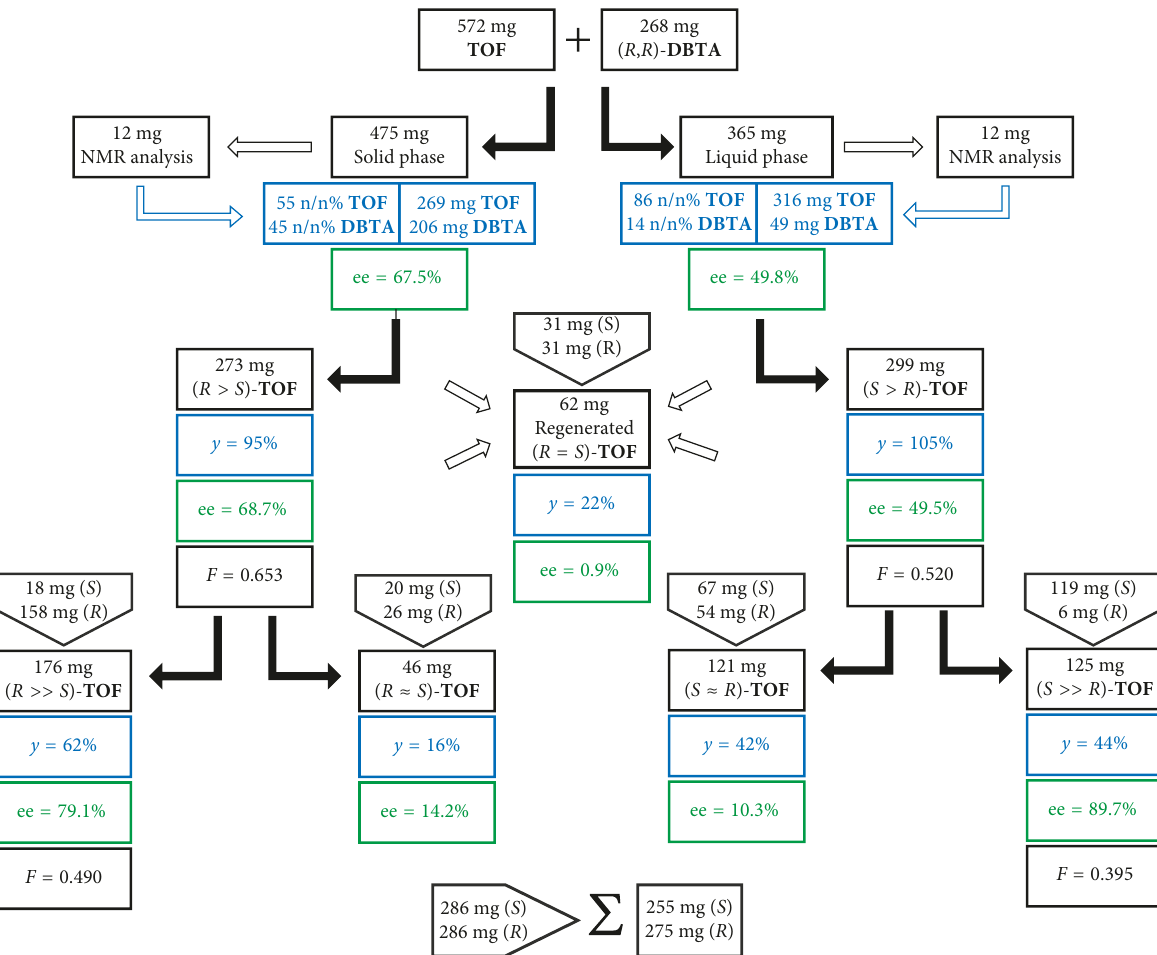
Scheme 15: Material balance of the resolution of racemic TOF by ( R , R )- DBTA